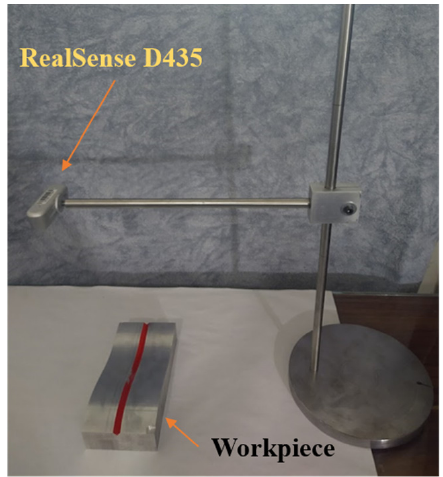
Figure 3. Experimental setup: camera mounted on a pedestal with top view of the working object.